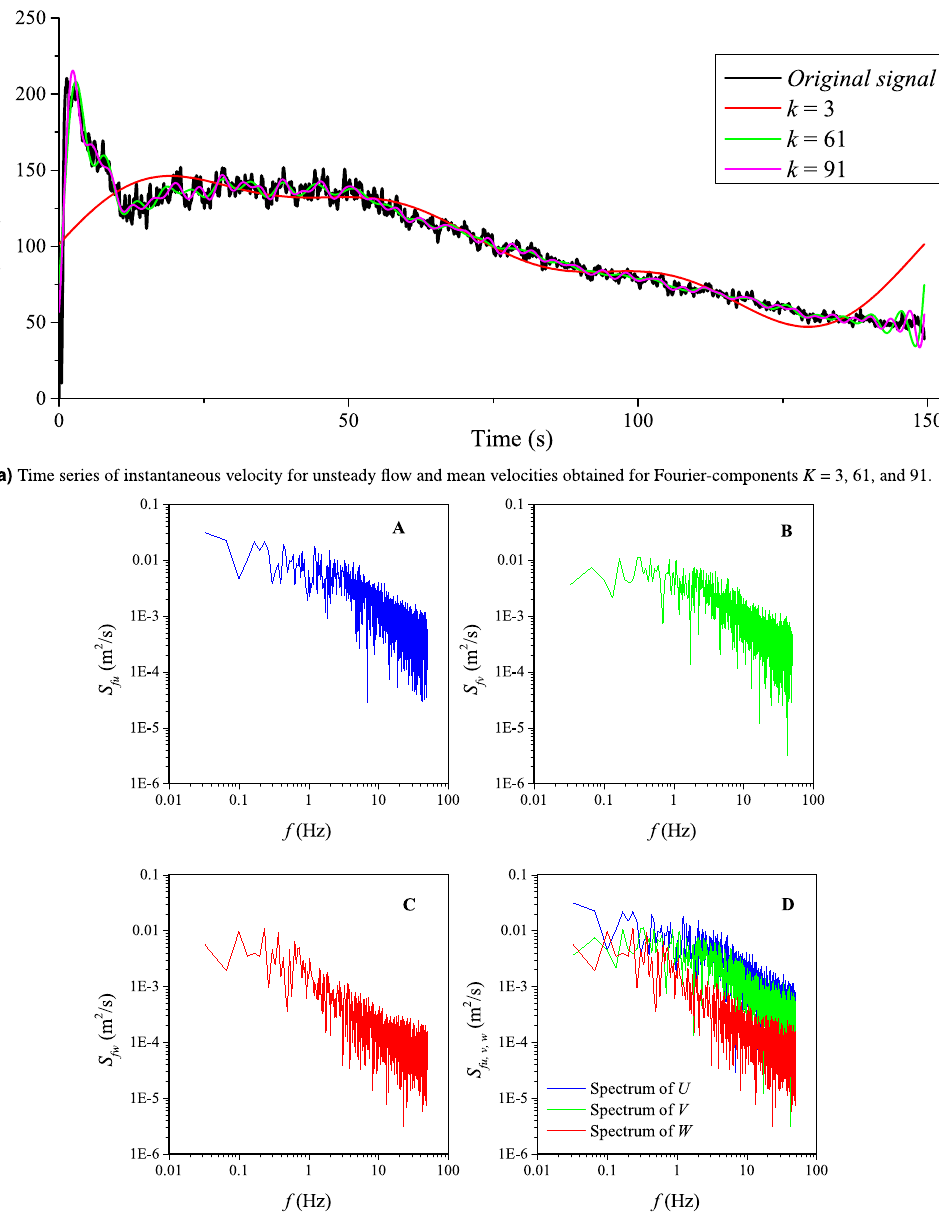
Figure 8. Visualizations that can be derived from the P-SAT framework (Continued...).